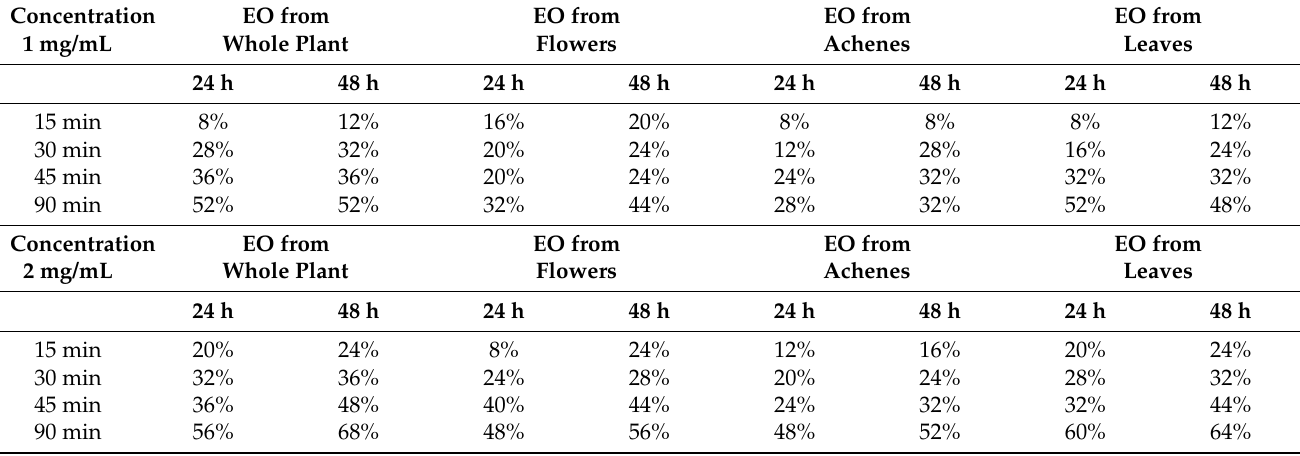
Table 3. Mortality percentages related to subacute toxicity at (above) 1 mg/mL concentration and (below) 2 mg/mL